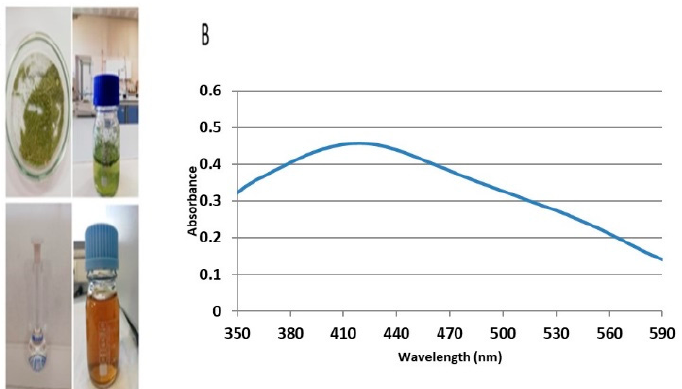
Figure 1. ( A ) Biosynthesis of silver nanoparticles, ( B ) along with UV–visible spectrophotometer image.